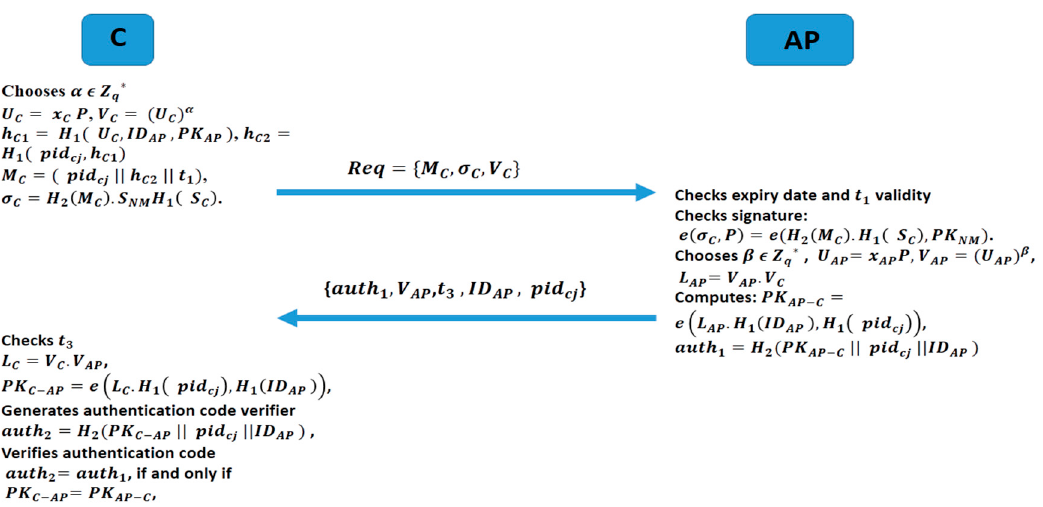
Figure 3. C and AP authentication process